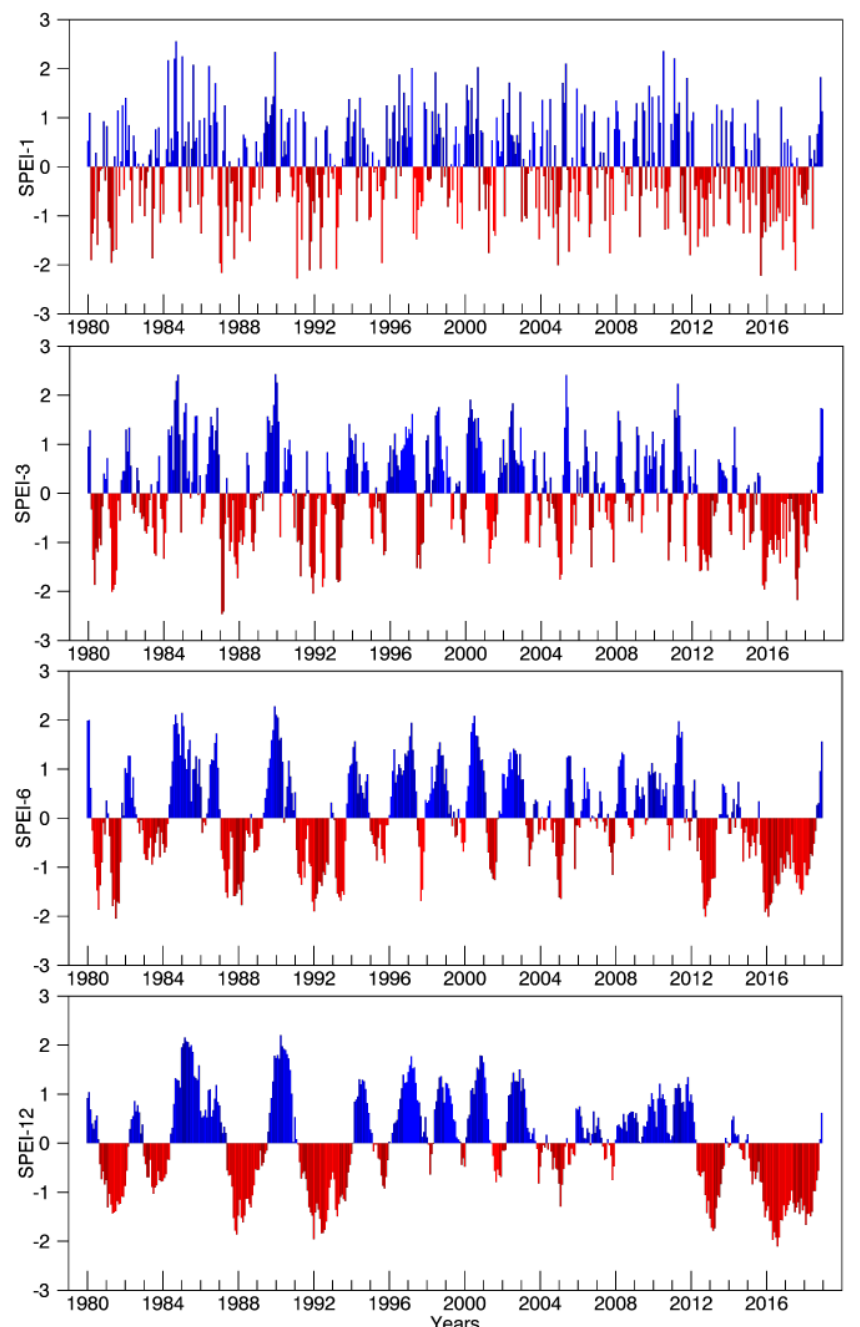
Figure 2. Time series of Standardized Precipitation – Evapotranspiration Index at the accumulation period of one month (SPEI-1), three months (SPEI-3), six months (SPEI-6), and twelve months (SPEI-12) for the ESA during 1980 – 2018. Data are computed from CRU TS 4.03.